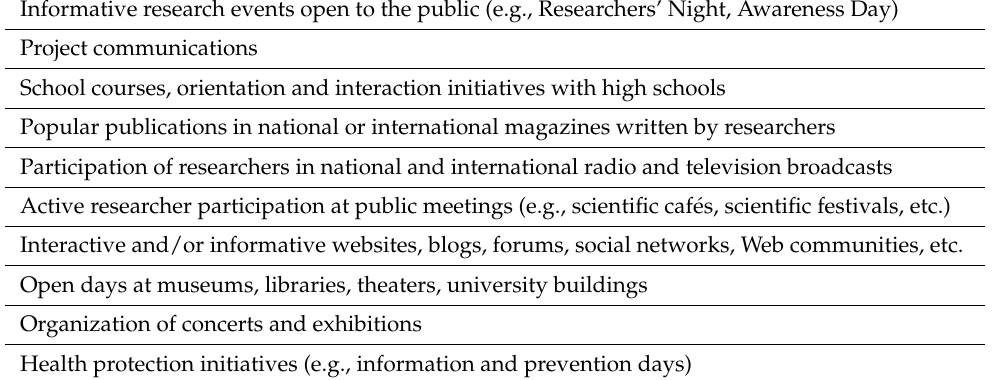
Table 1. Ways of providing information on processes and results of research